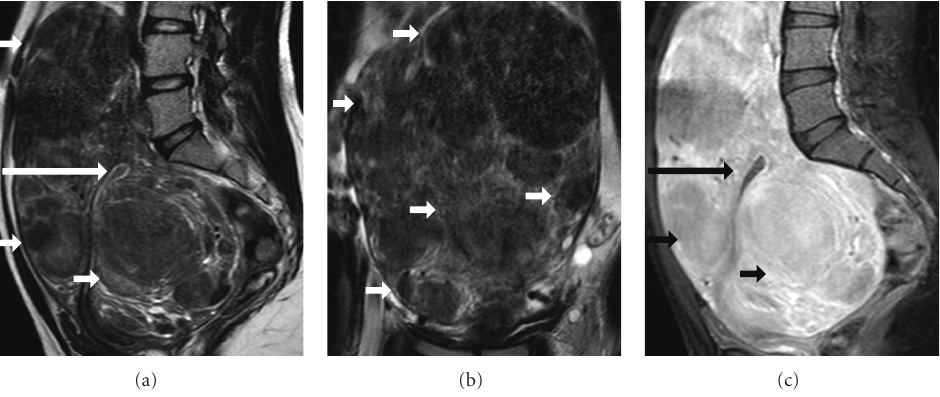
Figure 2: Sagittal (a) and coronal (b) T2-weighted MR images show uterus enlargement. Multiple, relatively homogeneous fibroids are revealed (arrows), of low signal intensity, causing significant compression of the uterine endometrial cavity (long arrow). (c) Sagittal fat- suppressed T1-weighed image depicts strong and heterogeneous lesion enhancement (arrows).